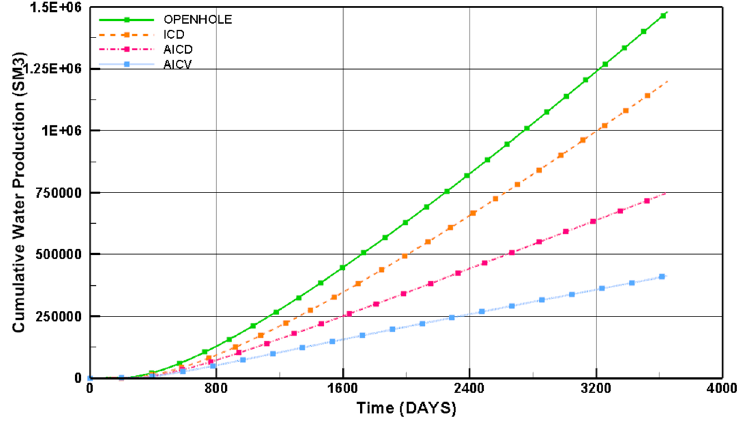
Figure 8. Cumulative oil and water production from open ‐ hole and advanced wells with different FCD completions for the base case.